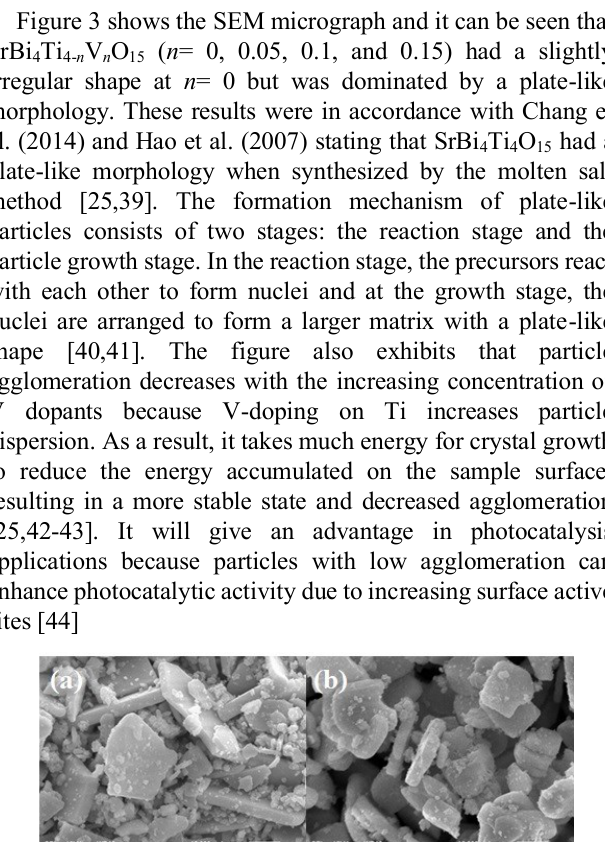
Fig 2. The refinement plot of SrBi 4 Ti 4- n V n O 15 ( n = 0, 0.05, 0.1, and 0.15) diffractogram